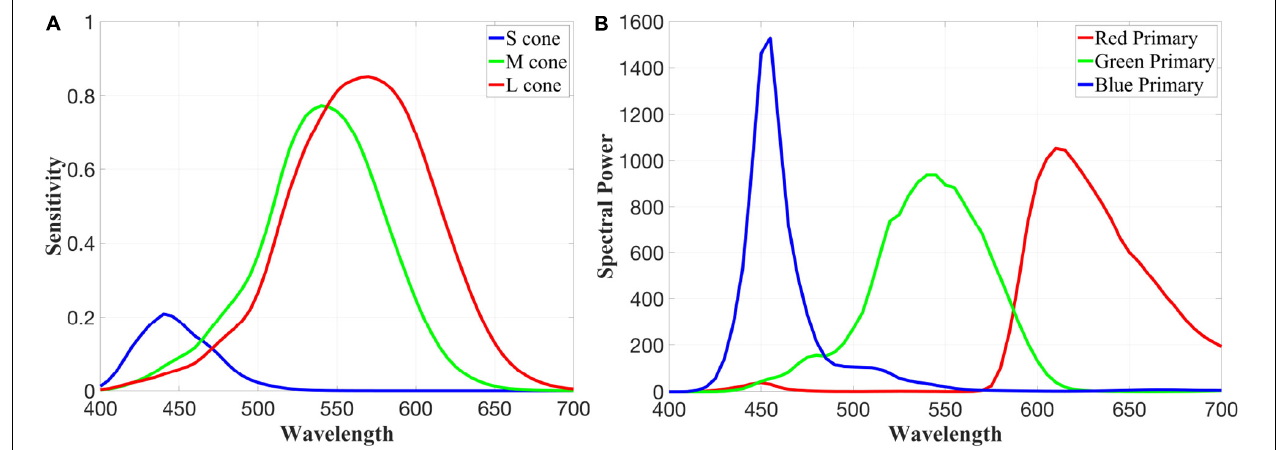
FIGURE 2 | Quantal LMS cone fundamentals (A) and the measured red, green, and blue primaries of our LCD display (B) that has been adjusted to have a white point equivalent to equal energy